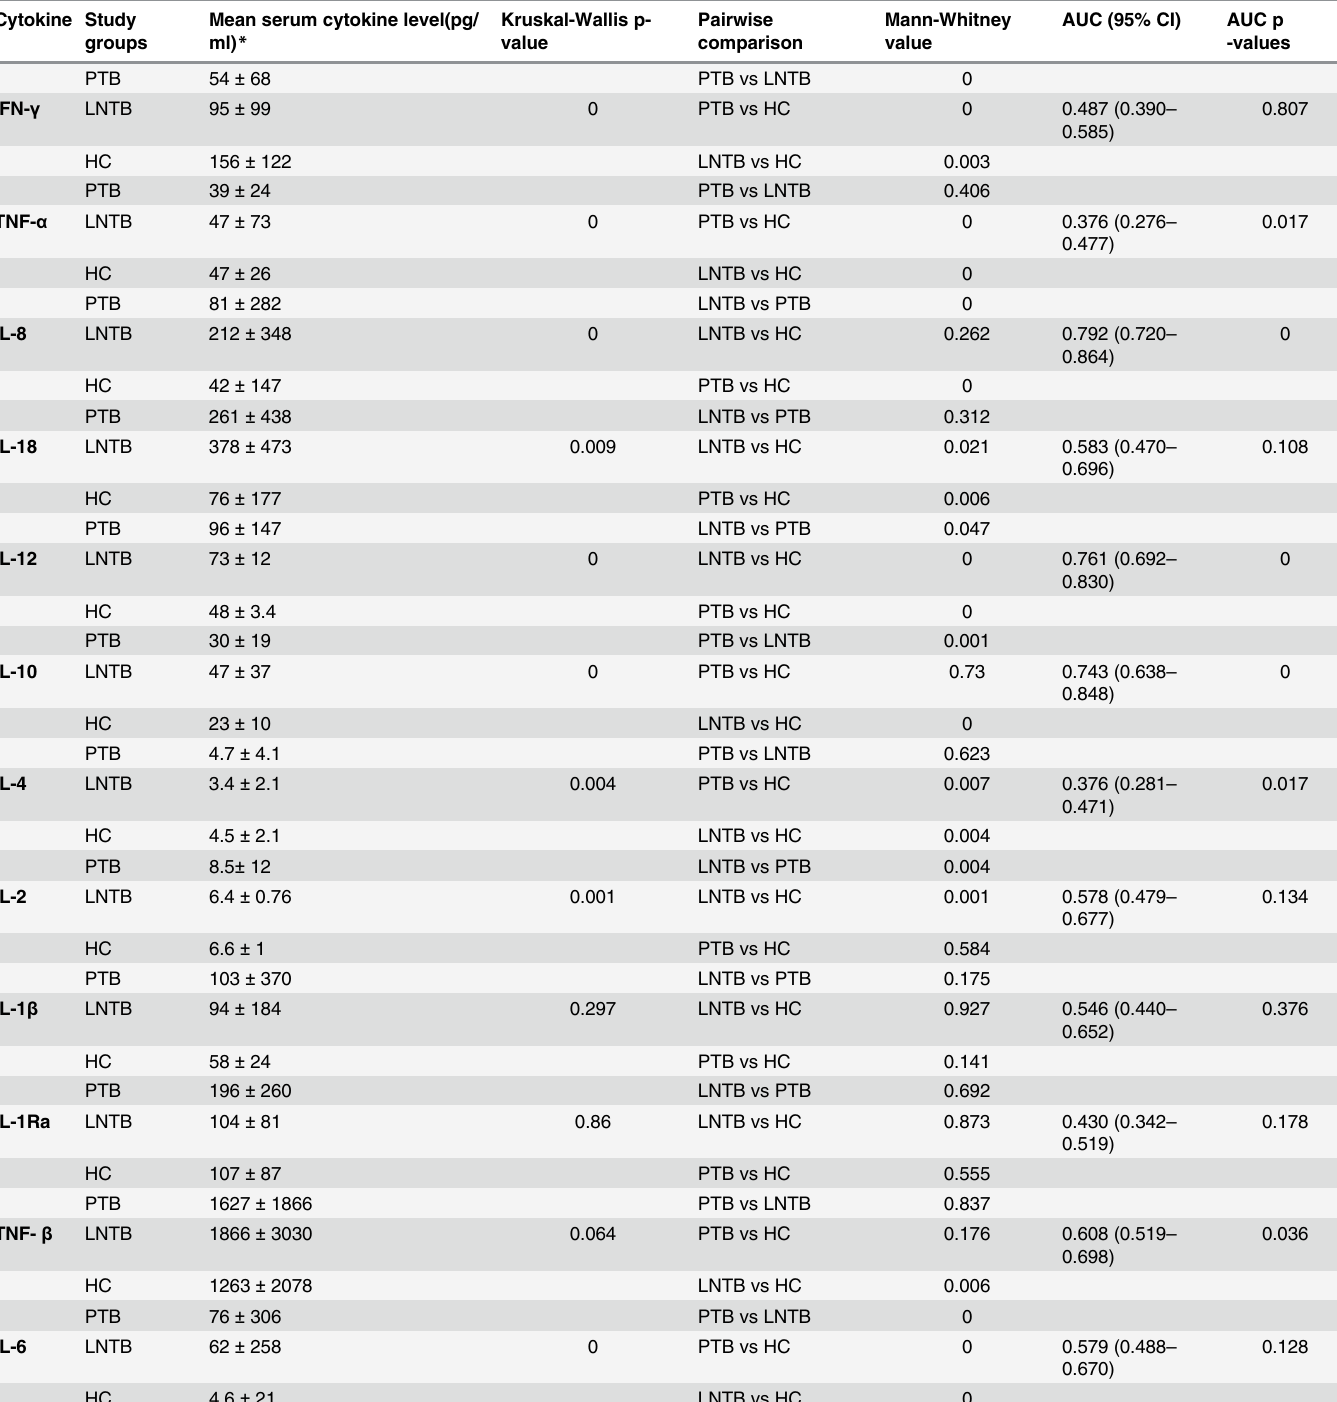
Table 2. Individual biomarkers tested in the discovery cohort and their efficacy in distinguishing the study